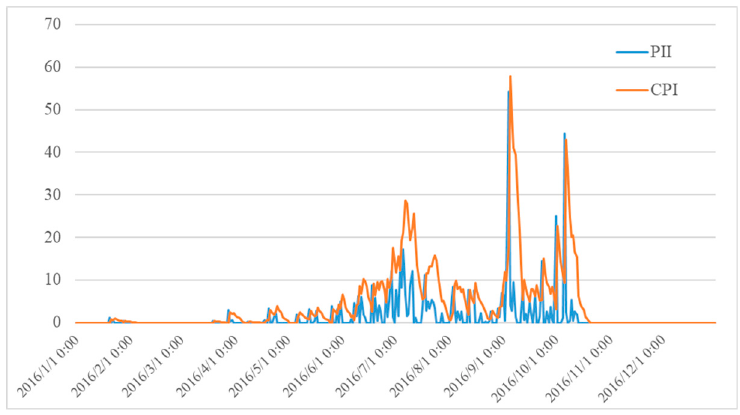
Figure 4. PII and CPI curve of an observation point from 2016/01–2016/12.